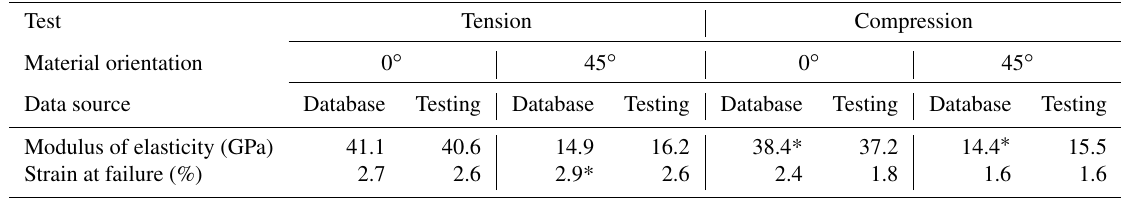
Table 5. Comparison of control test results to published MSU composite database results in tension and